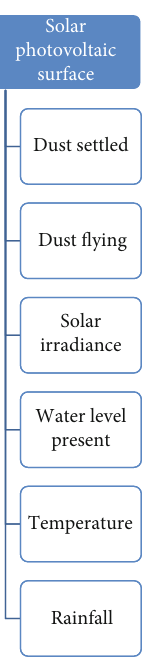
Figure 1: Main sources of data collection on PV